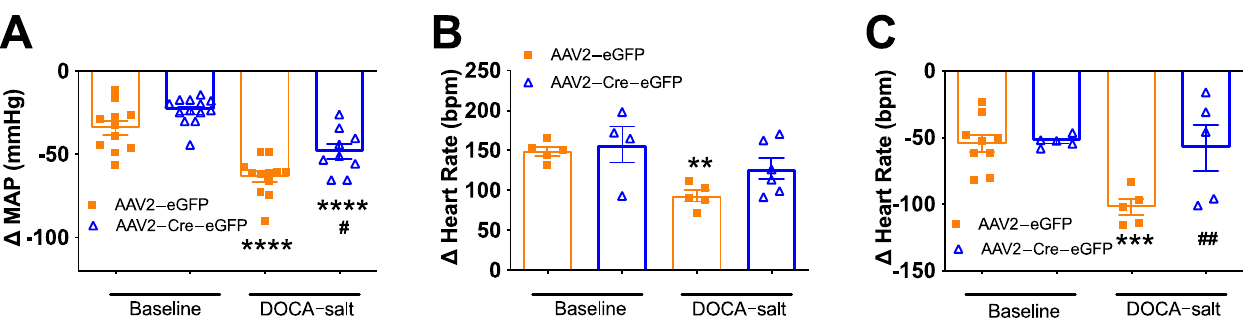
Figure 8. Renin-a deletion in the SFO improves autonomic function in DOCA-salt hypertensive mice. Autonomic function was assessed by intraperitoneal injection of the ganglionic blocker chlorisondamine (6 mg/kg), muscarinic receptor blocker methylatropine (1 mg/kg), or β -adrenergic receptor blocker propranolol (5 mg/kg). ( A ) Reduction in BP response to chlorisondamine, indicative of the neurogenic contribution to BP (n = 9–13 mice/group). ( B ) Increase in HR response to methylatropine, indicative of cardiac parasympathetic tone (n = 4–6 mice/group). ( C ) Reduction in HR response to propranolol, indicative of cardiac sympathetic tone (n = 5–9 mice/group). ** p < 0.01, *** p < 0.001, **** p < 0.0001 versus baseline; # p < 0.05, ## p < 0.01 versus AAV2-eGFP DOCA-salt (one-way ANOVA with Fisher’s LSD test).